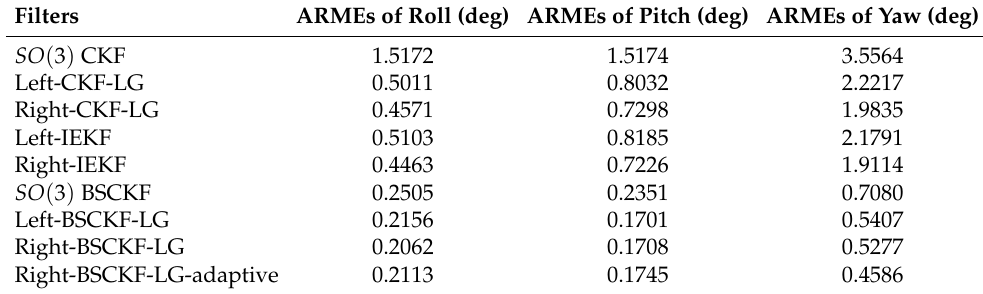
Table 1. ARMSEs of Euler angles in Case